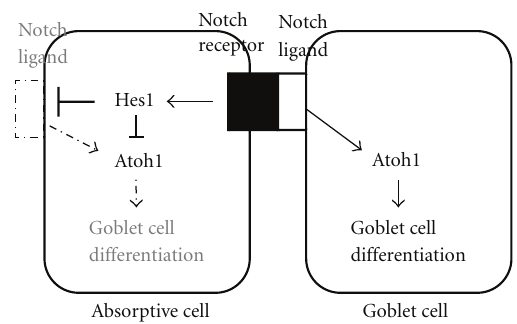
Figure 1: A schematic representation of lateral inhibition by a Notch ligand. A Notch ligand secreting cell releases a Notch ligand that binds to the Notch receptor of a neighboring cell. The action inhibits the activity of Atoh1 through Notch target gene Hes1 in the cell, leading to the formation of an absorptive cell. While a Notch ligand secreting cell has a high activity of Atoh1, leading to the di ff erentiation of a goblet